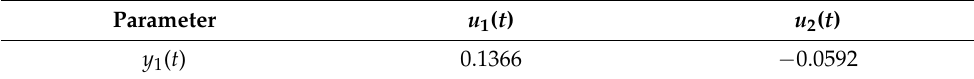
Table 1. Correlation coefficients of variables u 1 ( t ), u 2 ( t ), y 1 ( t ) [22].